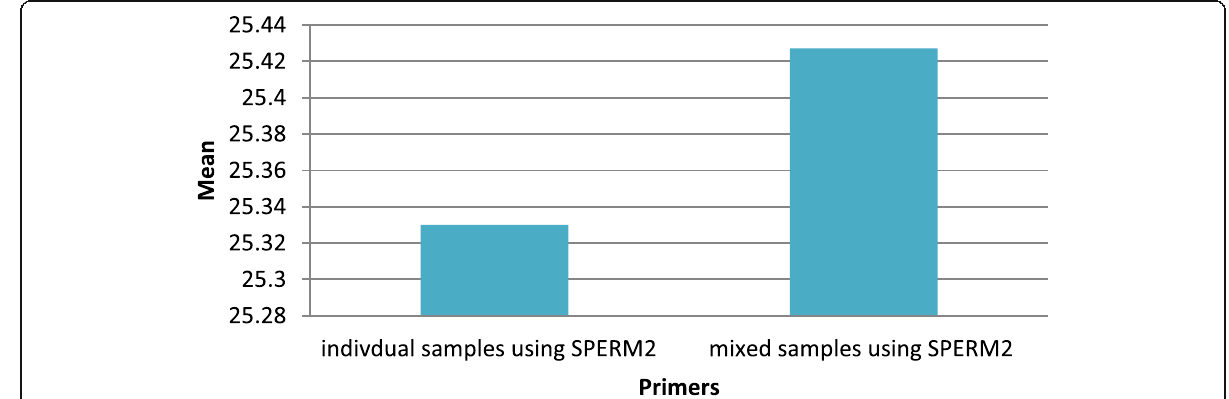
Fig. 4 Comparison between Cq values of SPERM2 amplification in individual semen samples and mixed body fluids